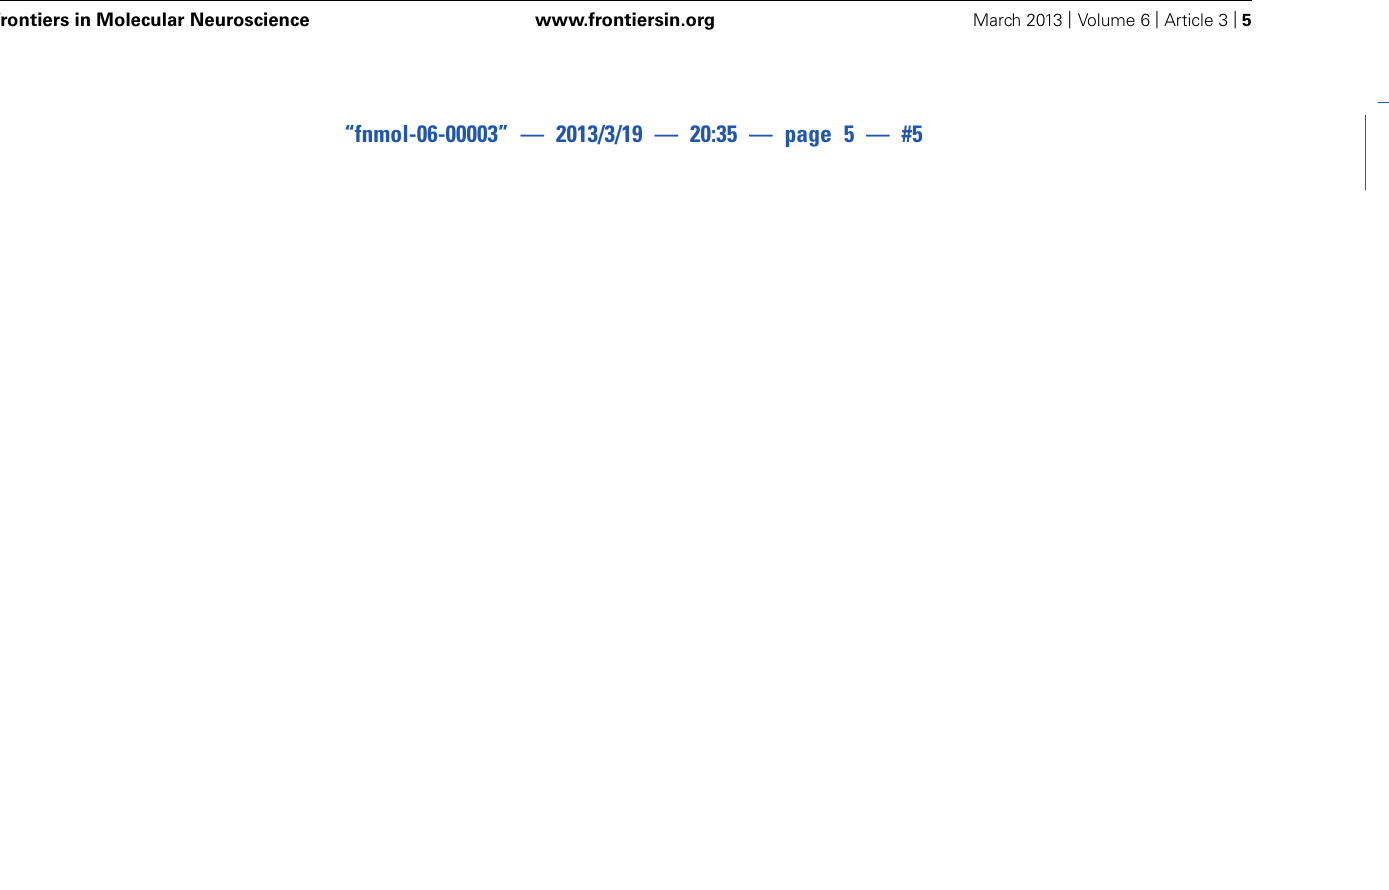
VGCC in hippocampal neurons. Current density–voltage relationship in absence (gray) and in presence of the toxin cocktail (black) measured in the same neuron. Isolation of the Ca 2 + current was obtained by blocking voltage-gated Na + channels with 1 μ M ofTTX in the physiological bath solution, where up to 91.6% of theVGCC currents were inhibited ( N = 4 cells with cell capacitance between 14.5 and 26.5 pF). Error bars indicate ± SEM. (D) Representative voltage recording from postsynaptic neuron in the presence ofVGCC blockers, purple bar indicates 2 s, 380 nm